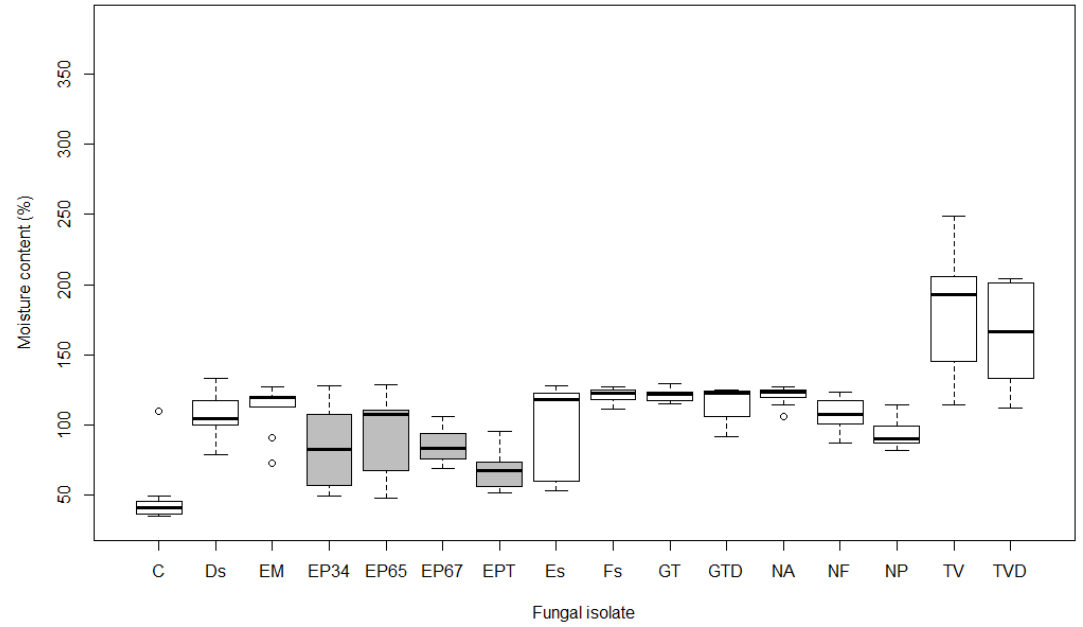
Figure 4. Boxplots showing moisture content (%) after 15 weeks of exposure to different fungal isolates in Acer pseudoplatanus (see Table 1 for labels of isolates; boxes of E. parasitica isolates are grey). Boxplot represents minimum, first quartile (Q 1 ), median, third quartile (Q 3 ), and maximum value.